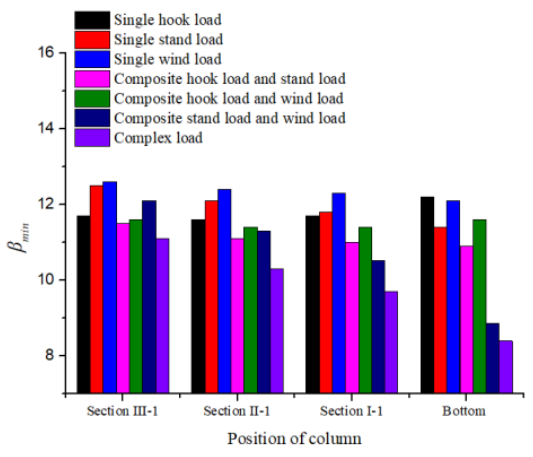
Figure 12. The minimum reliability index under each load condition.